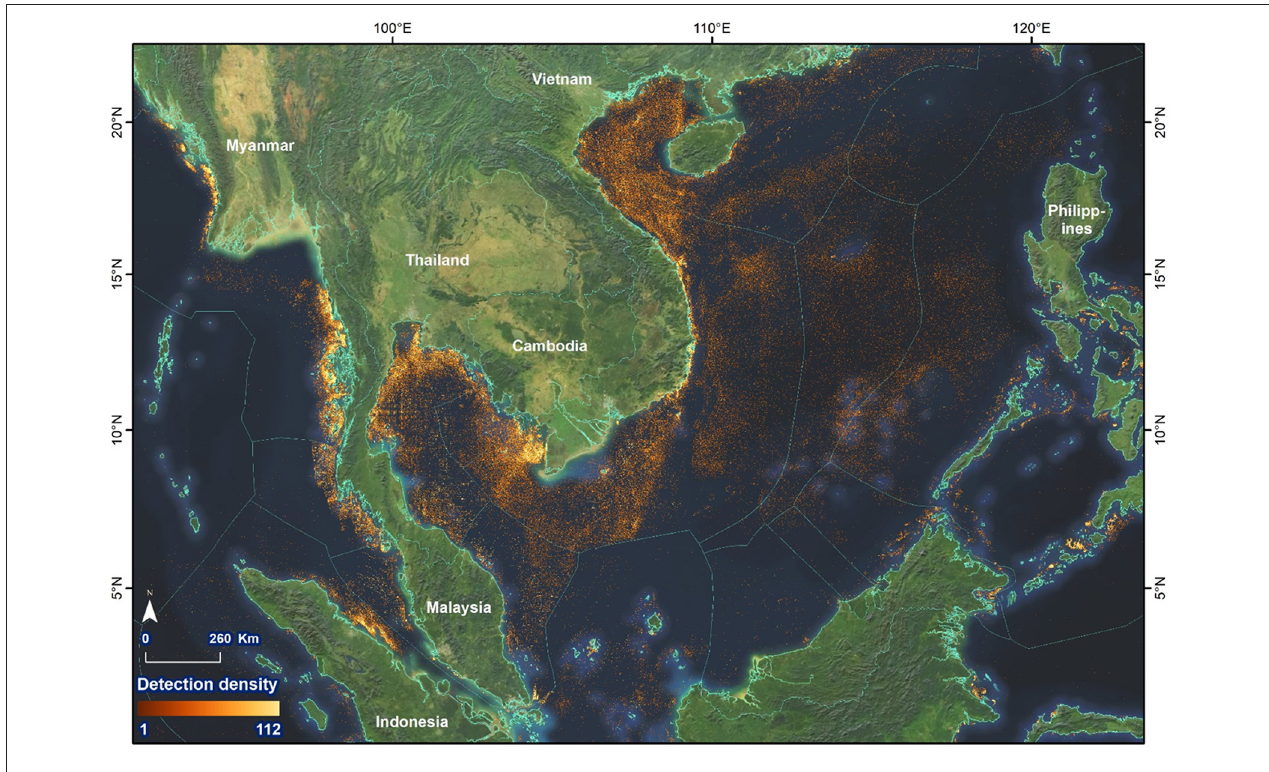
FIGURE 7 | VBD records across Southeast Asia. Showing cumulative detections recorded in 2019 at a 0.0042 degree ( ∼ 459m) grid cell resolution. Annual raster data downloaded from the EOG repository (https://eogdata.mines.edu/vbd/), accessed 29/06/2020.